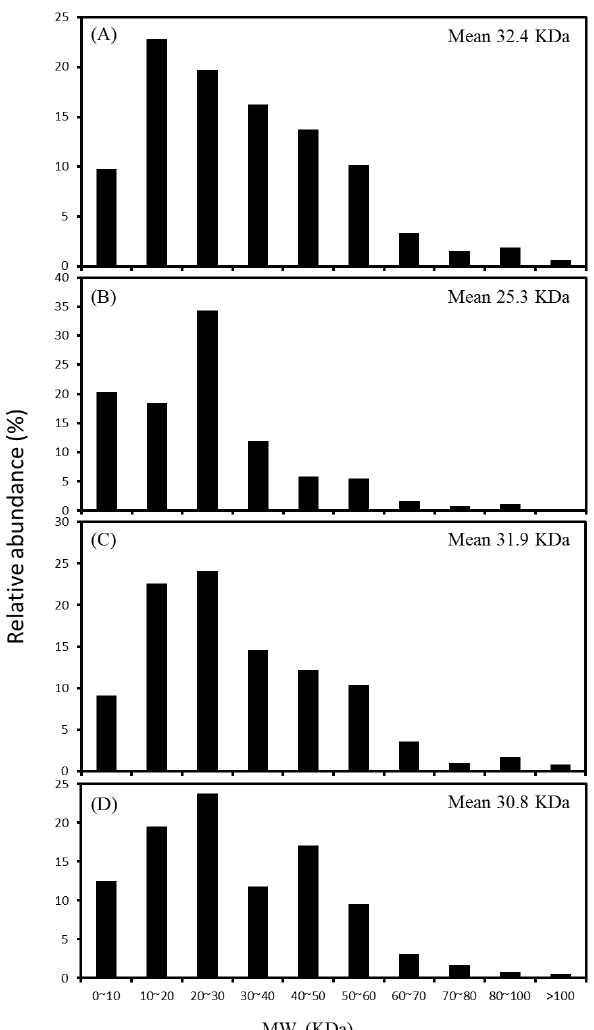
Figure 3. Distribution of molecular weight ( M SDS ( A ); Triton ( B ); CHAPS ( C ); and RIPA ( D )